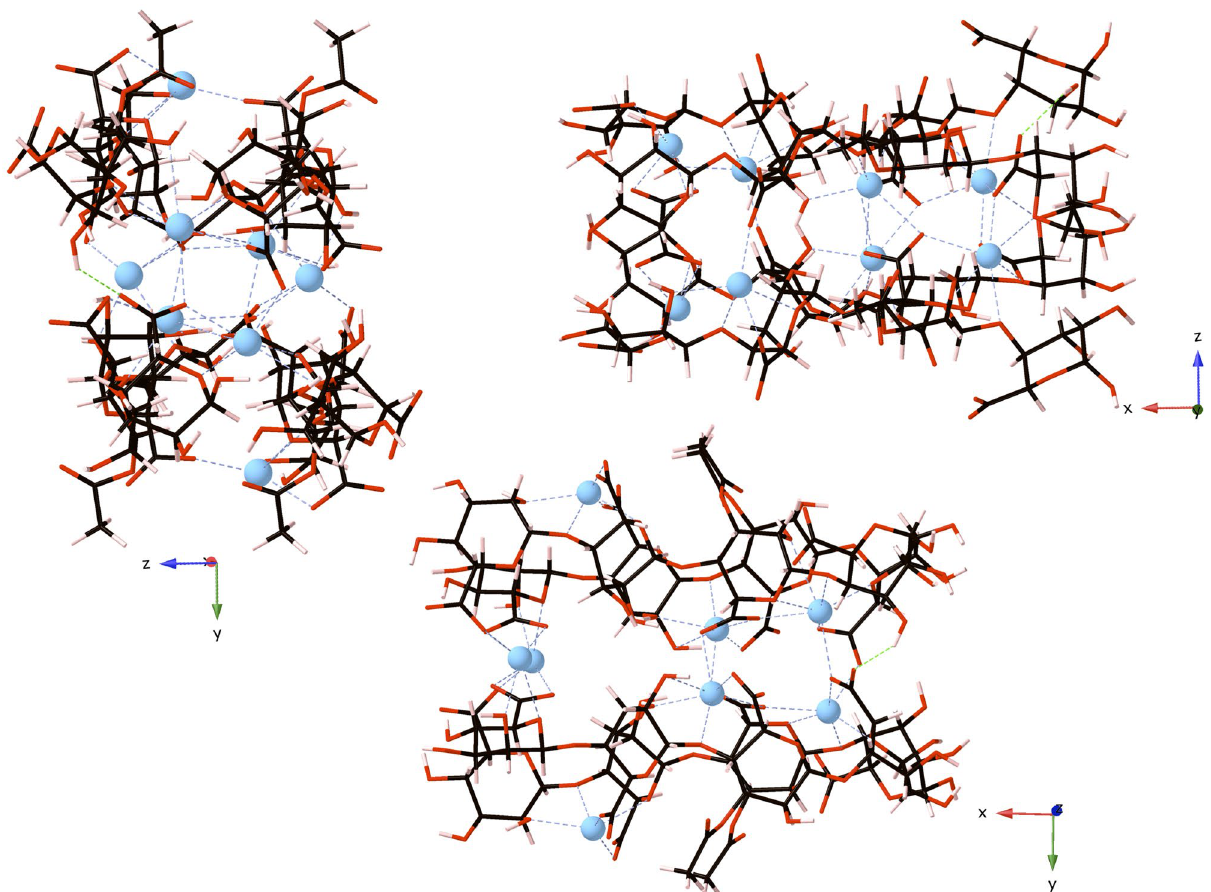
Figure 2. The 4-PolyMG* structure, corresponding to the most thermodynamically stable arrangement of four EPS chains complexed about Ca 2+ ions, viewed down the x, y and z axes. Carbon atoms are shown in grey, oxygen in red, calcium in blue and hydrogen in pink. Calcium–oxygen ionic bonds are shown with dashed blue lines and hydrogen bonds are shown with dashed green